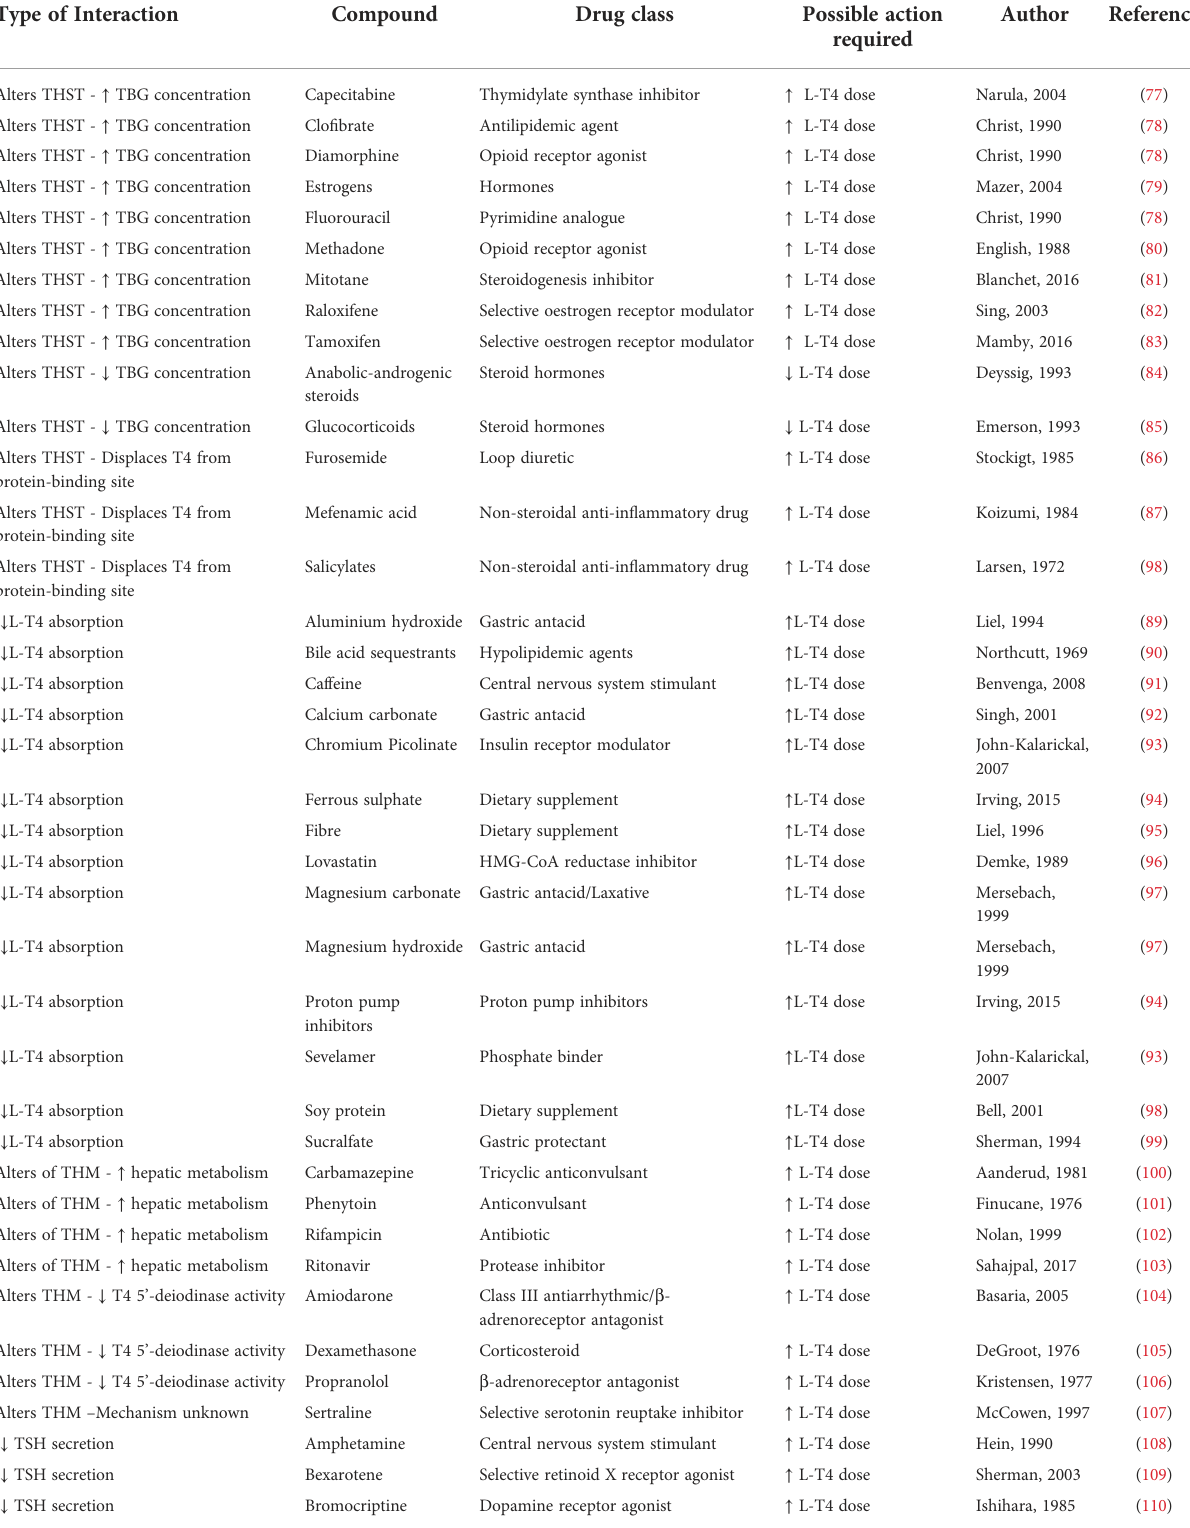
TABLE 2 Overview of interactions with levothyroxine (LT4): Compounds which have been recorded to interact with LT-4 and their effect on LT-4 metabolism, distribution and absorption are